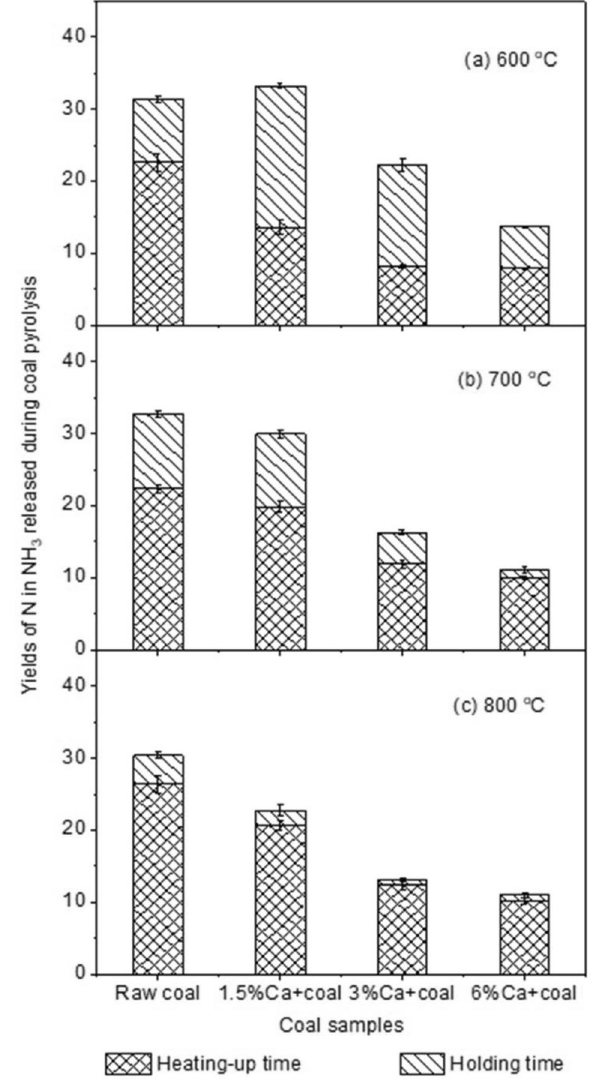
Fig. 2 The yields of NH 3 during the pyrolysis of raw coal and coal samples loaded with different contents of calcium at the heating-up time and holding time at different